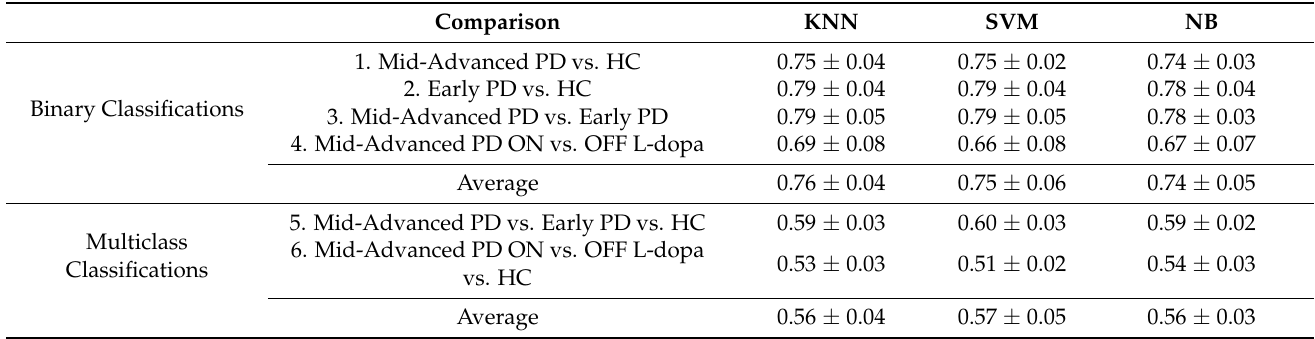
Table 5. Classification accuracy with respect to each ML model employed. The results are expressed as the average (and standard deviation) of the CV performance yielded by CFS, IG, and